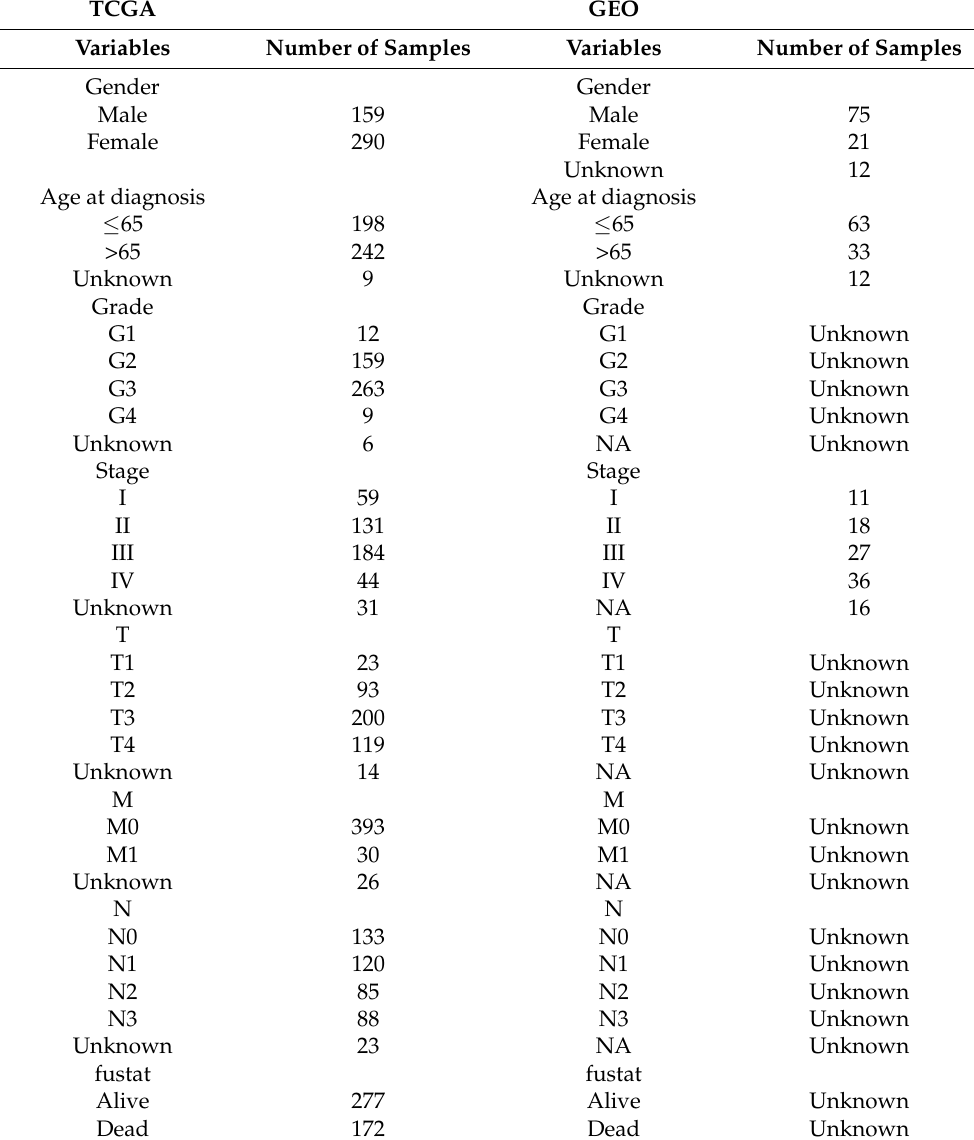
Table 1. Clinical